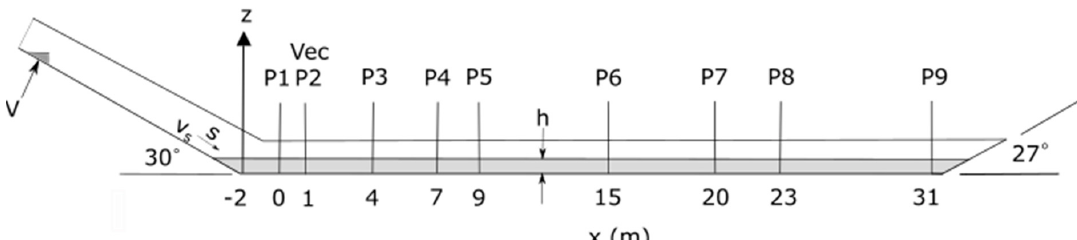
Figure 1. Landslide flume experimental apparatus, indicating the locations of wave probes (P1–P9) and acoustic velocity sensor (Vec). The numerical modeling domain begins at x = 0, with boundary conditions from observations at P1.